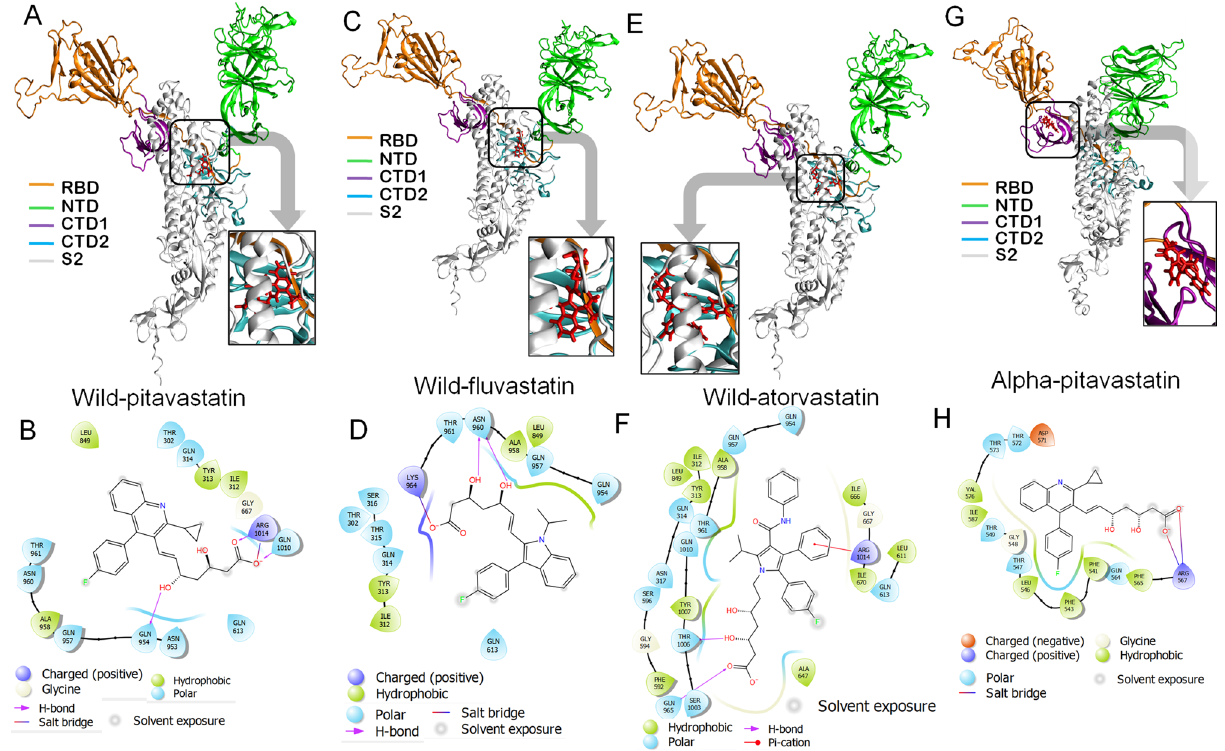
Figure 7. Molecular docking study of pitavastatin, Fluvastatin, and atorvastatin to Spike WT and Spike Alpha, respectively. (A,C,E) 3D diagram of pitavastatin Spike WT complex, fluvastatin Spike WT complex, and atorvastatin Spike WT complex, respectively. (B,D,F) 2D diagram for representation of interactions of pitavastatin, Fluvastatin, and atorvastatin molecules with the amino acid residues at the binding site of Spike WT . (G,H) 3D diagram of pitavastatin–Spike Alpha complex and 2D diagram for representation of interactions of pitavastatin, Fluvastatin, and atorvastatin molecules with the amino acid residues at the binding site of Spike Alpha. All 3D images were generated using the VMD (visual molecular dynamics) software (version 1.9.3) and 2D images were generated by the graphical user interface Maestro, Schrödinger (https:// www. schro dinger. com/ produ cts/ maest